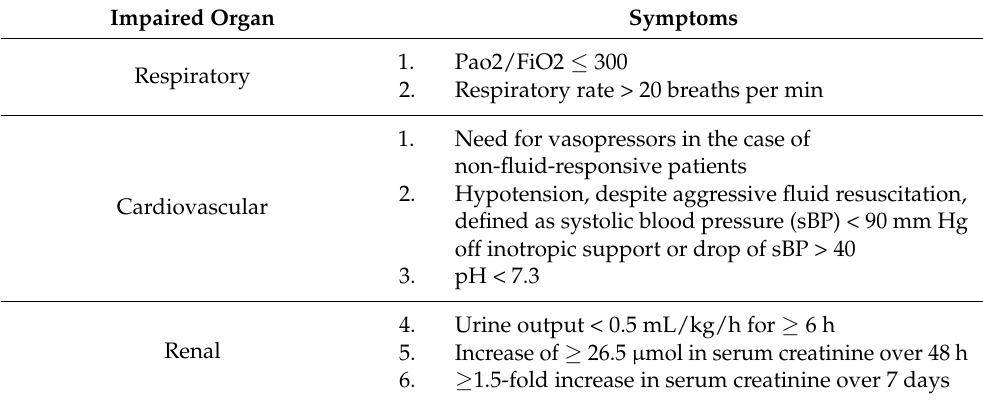
Table 6. Symptoms indicating the current or progressing organ dysfunction in the course of acute pancreatitis, the presence of which is a criterion for consideration of admission to a monitored unit. Impaired